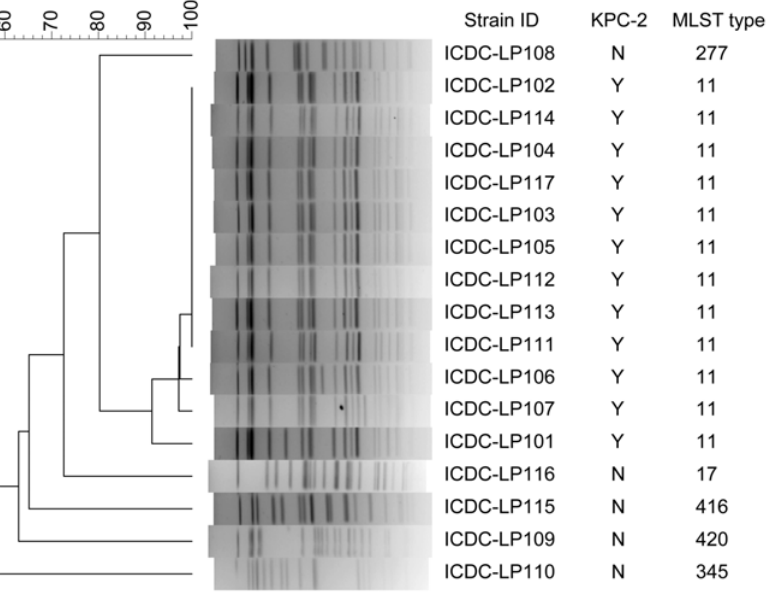
Figure 6. Comparing of PFGE ( Xba I digestion) and MLST to subtype K. pneumoniae strains isolated during an outbreak